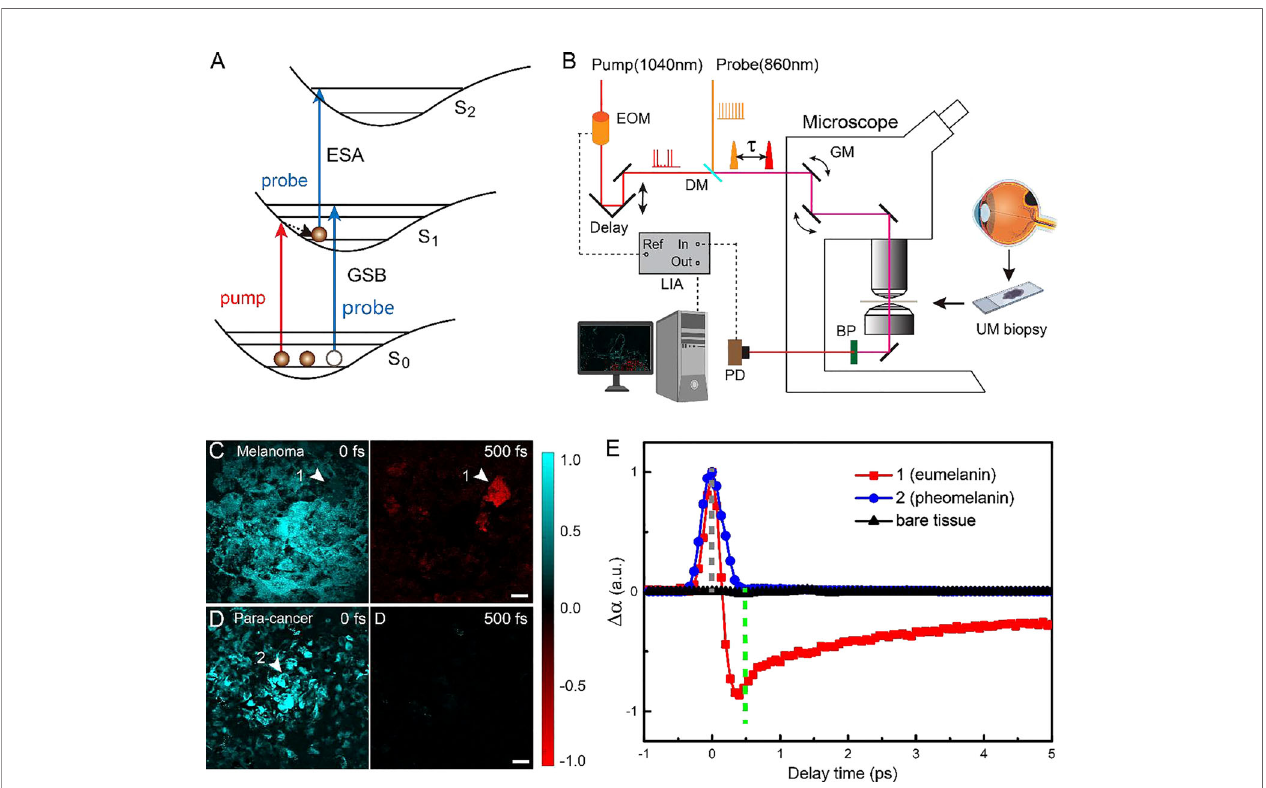
FIGURE 1 | Experimental design and transient optical behaviors of melanin in uveal melanoma (UM). (A) Optical transitions of pump-probe processes. (B) Optical layout of the pump-probe microscope. EOM, electro-optic modulator; DM. dichroic mirror; t , interpulse delay between pump and probe; GM, galvo mirror; BP, band-pass fi lter; PD, photodiode; LIA, lock-in ampli fi er; ESA, Excited-State-Absorption; GSB, Ground-state bleach; Fs, femtosecond; ps, picosecond. (C, D) Typical pump-probe images of cellular debris excised from melanoma and paracancerous tissues, taken at 0 and 500 fs interpulse delays. (E) Time-resolved transient absorption (TA) dynamics of the two melanin species measured at the representative areas 1 and 2 [arrowheads in panels (C, D) ]. Scale bar: 20 m